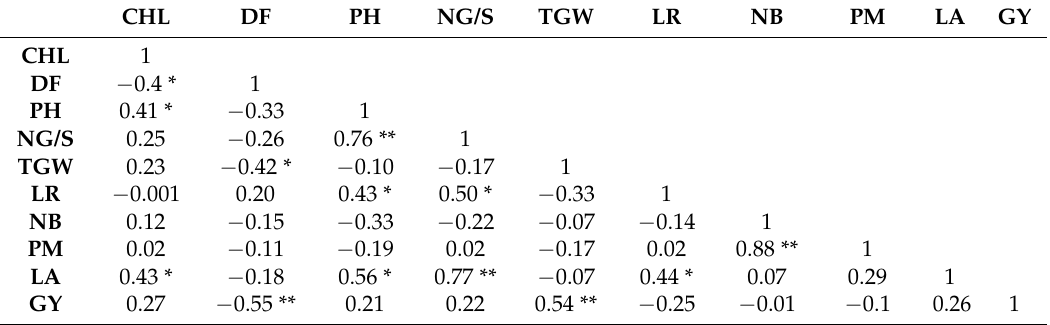
Table 4. Correlation coefficients among the studied traits across the three environments.